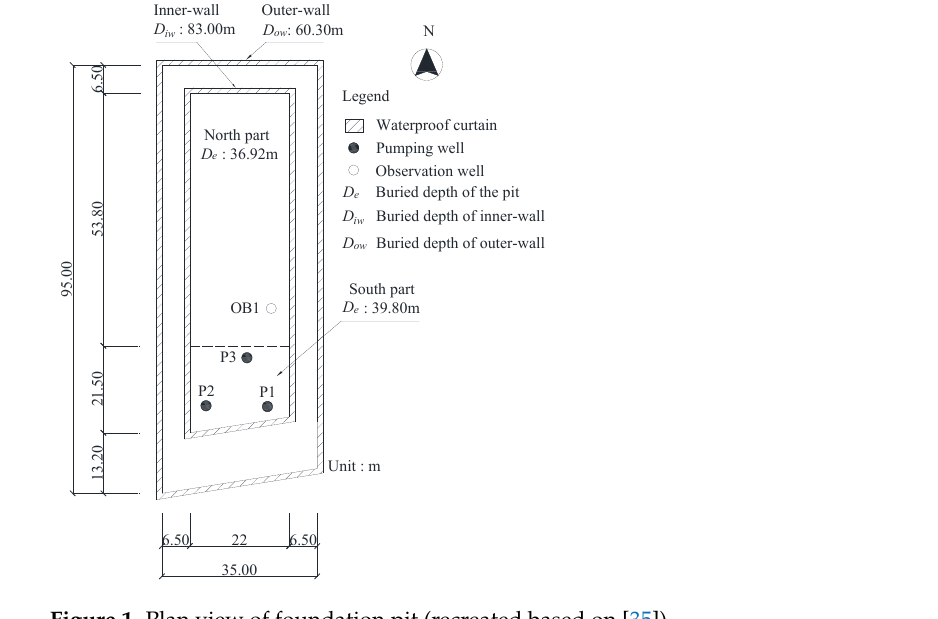
Figure 1. Plan view of foundation pit (recreated based on [35]).